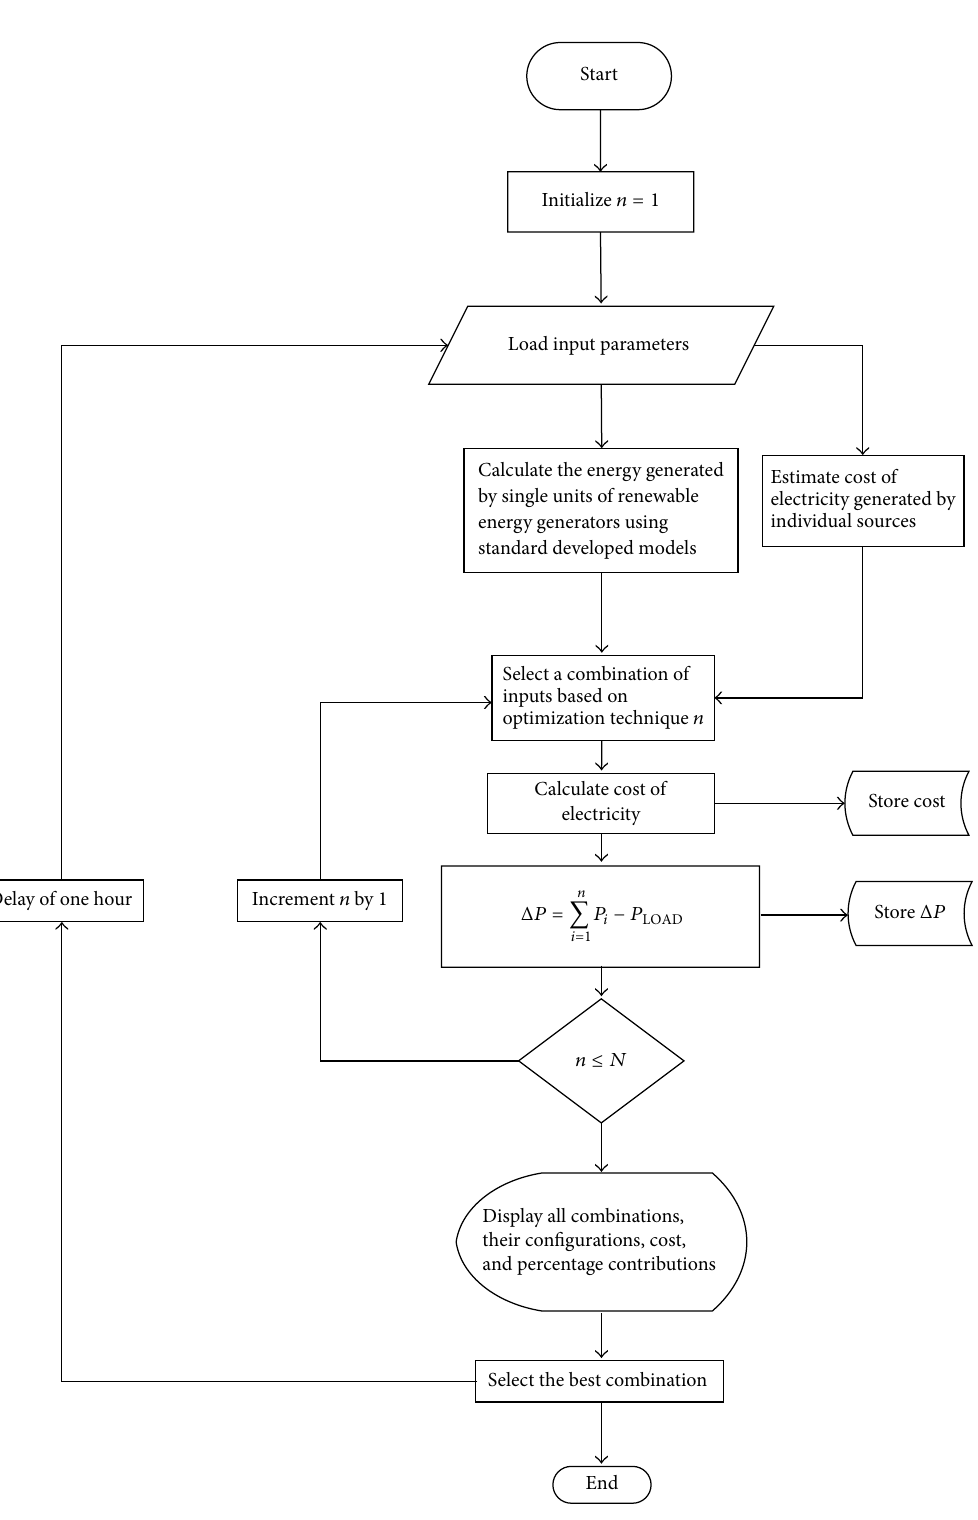
Figure 2: Hybrid system optimization